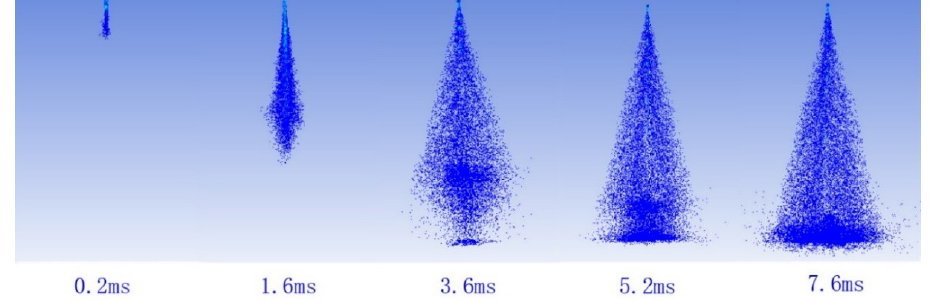
Figure 12. Development of spray outside the nozzle (Δ = 4.3).